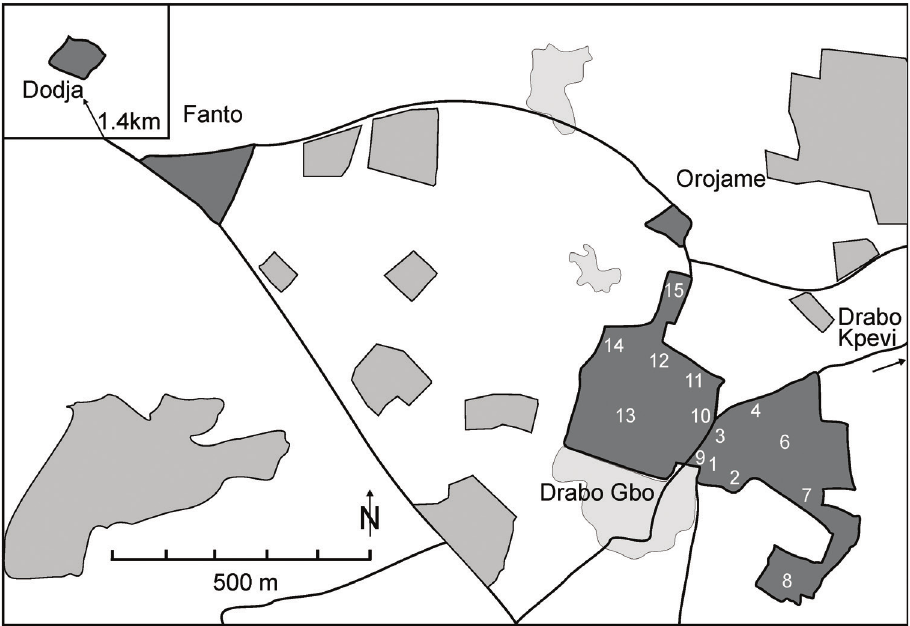
Figure 3. Map of Drabo forests with year of purchase and start of forest management, major clearings: 1 nursery-garden 1997 (house constructed 1997-1998) 2 papa-garage 1999, 2000 3 Lissanou 1999–2003 4 mill 2000 5 Gaston part of Cooun cleared in 2010 6 Cooun 2001 7 corridor-Dansou 2004, 2010 8 Emile 2001–2007 partly cleared 2012 9 ‘Maison de Jeunesse’ (MdJ house constructed 2005) 1998, cleared in 2013 10 Tofinou 1998-2000 11 Pierre 1999–2001 12 Kakpo 2004 13 Grande Forêt 1996, local fire in 2012 14 AgoXwè 2000–2003 15 Corridor north 1998, 2002–2003, Orojamè 1998, Fanto 1998–2000, partly cleared 2014, Dodja 2011, partly cleared 2016. Natural forests grey with border line, wood lots light grey with border line, compact villages light grey, unsurfaced roads as